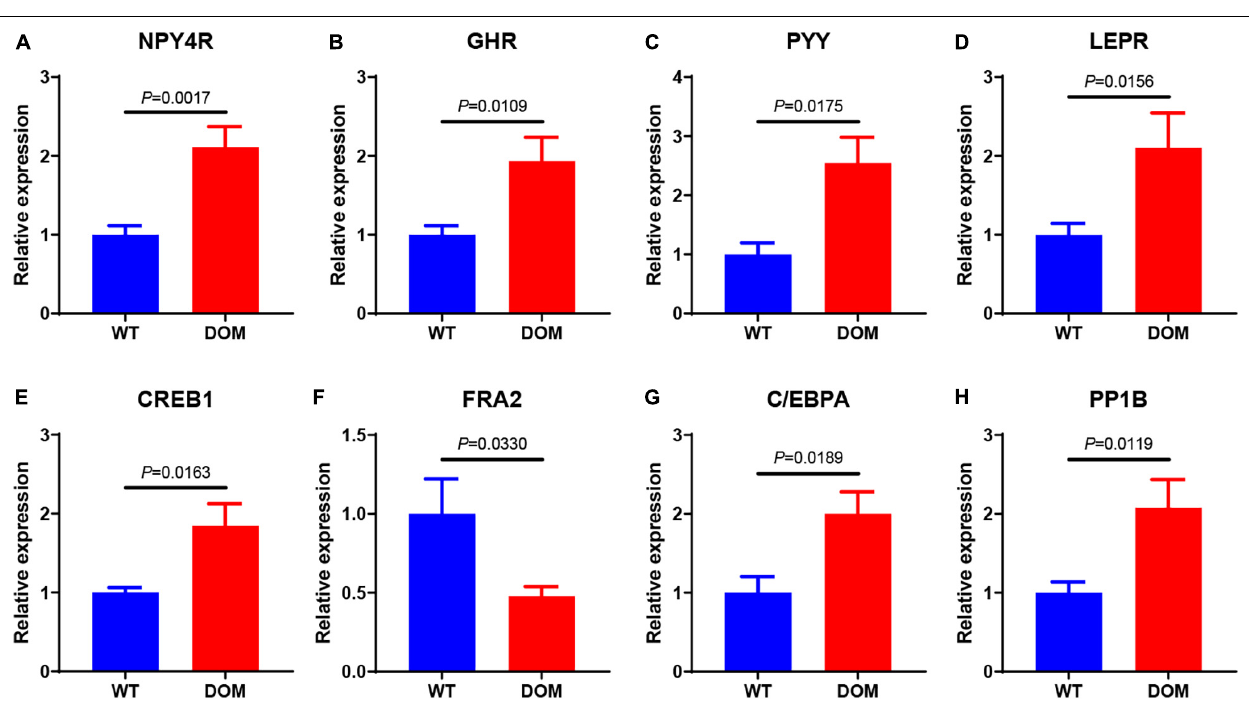
FIGURE 2 | Feed domestication improves appetite and perception in the brain of A. grunniens . Transcriptional expression of appetite-related (A–D) and perception-related (E–H) genes. (A) NPY4R, (B) GHR, (C) PYY, (D) LEPR, (E) CREB1, (F) FRA2, (G) C/EBPA, and (H) PP1B. Data were analyzed by Student’s t -test, and results were indicated as mean ± SEM, n =